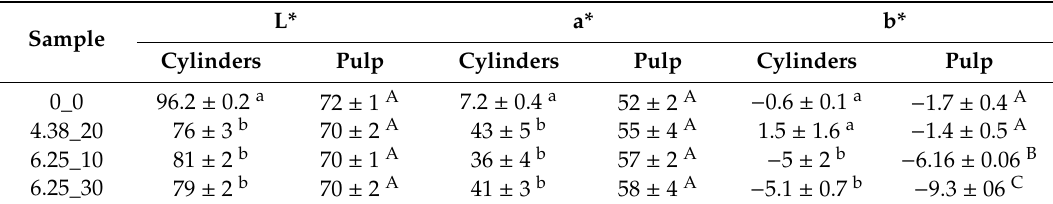
Table 3. Color parameters (L* = Lightness, a* = red / green index, b* = yellow / blue index) of extracts obtained from untreated and PEF-treated beetroot cylinders and pulp.